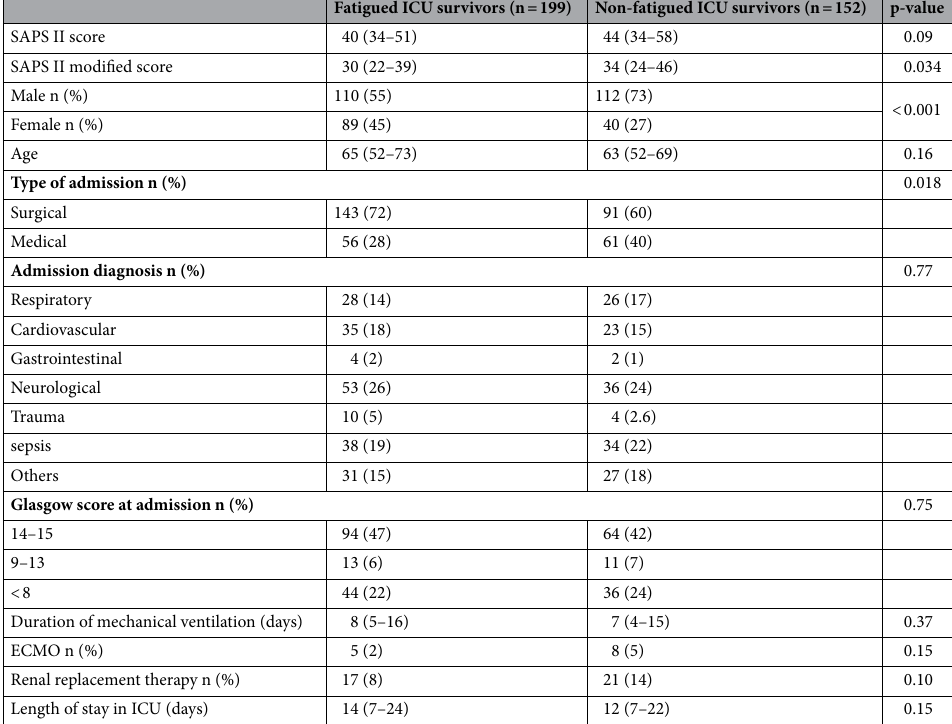
Table 1. Characteristics and outcomes of ICU survivors from the fatigued and non-fatigued groups. Data are presented as median with interquartile range. Categorical data are reported as number with percentage in bracket. SAPS Simplified Acute Physiology Score, ECMO extracorporeal membrane oxygenation, ICU intensive care